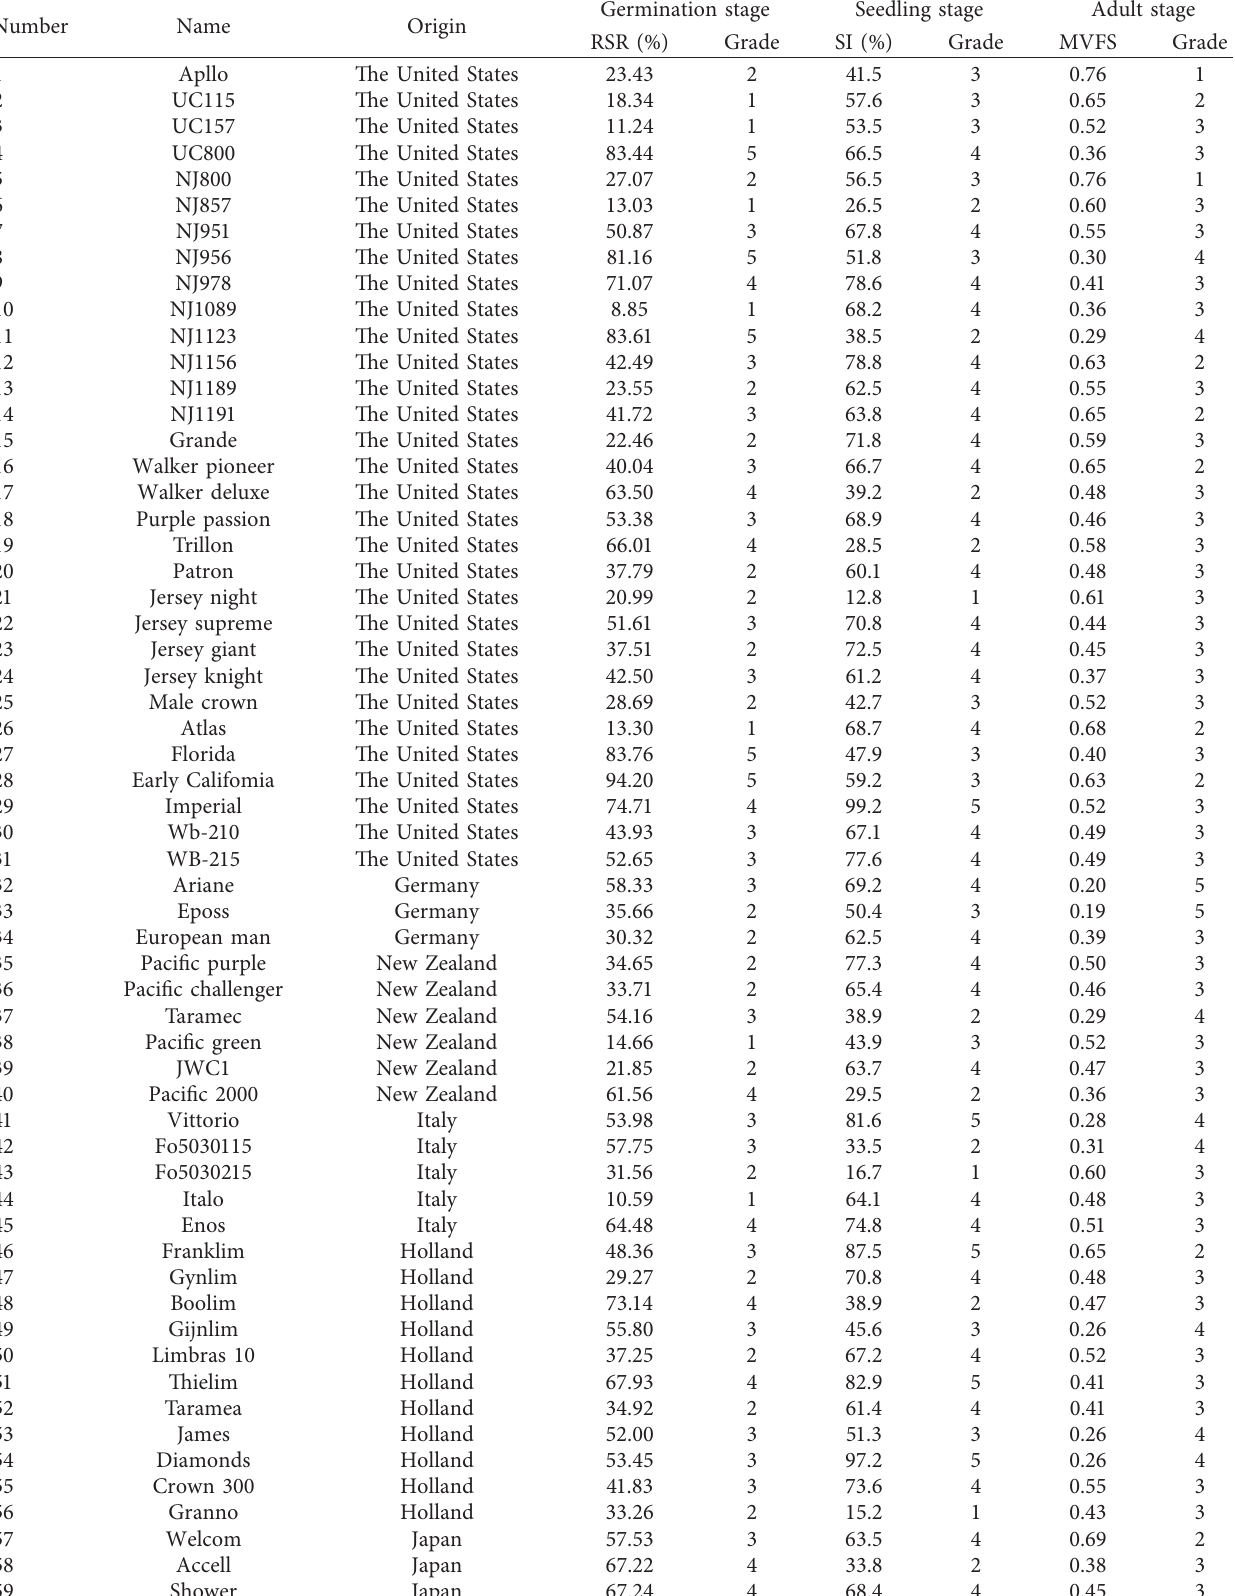
Table 1: Name, origin, and the salt tolerance grades of the 95 asparagus accessions at each growth